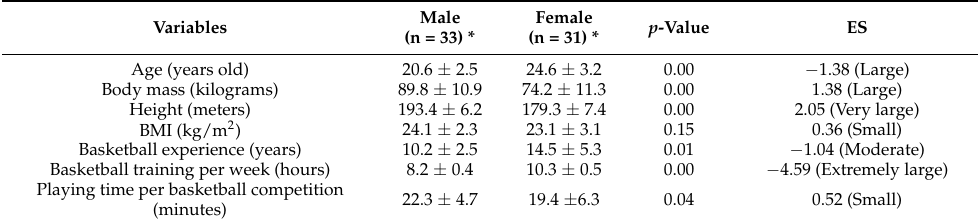
Table 1. Demographic and sports data from the competitive basketball